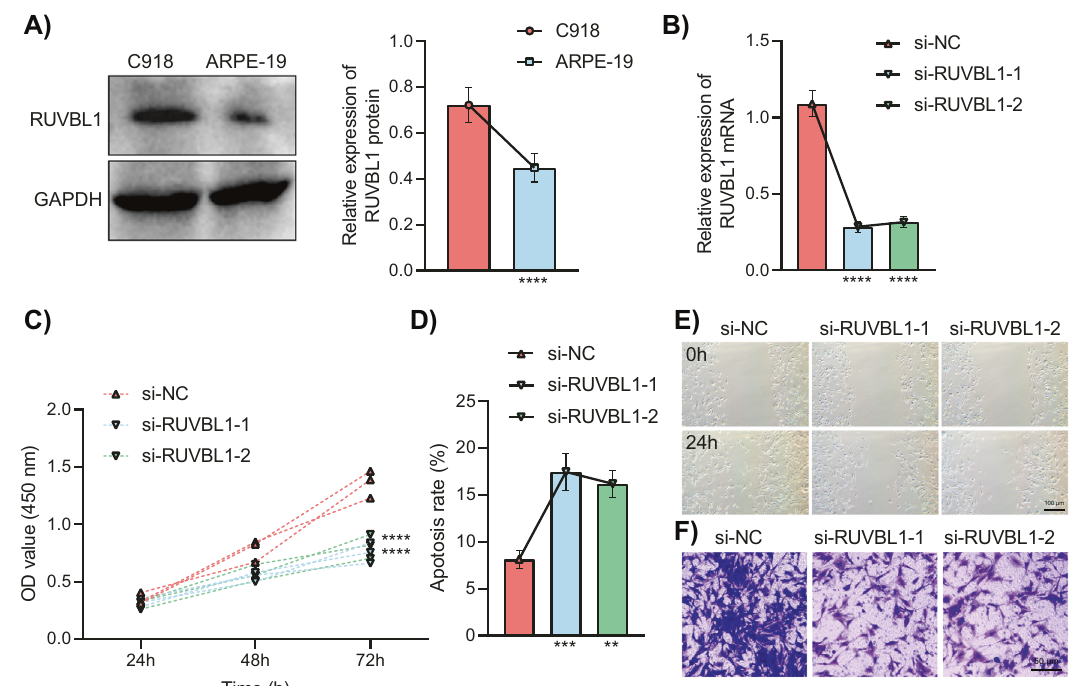
Fig. 5 Effects of RUVBL1 knockdown on the biological properties of UVM cells. A The expression of RUVBL1 in the C918 and ARPE-19 cells determined by Western blot analysis, ****, p < 0.0001. B The relative expression level of RUVBL1 in C918 cells transfected with si-RUVBL1-1 and si-RUVBL1-2 determined by RT-qPCR, **** p < 0.0001. C The proliferative capacity of C918 cells transfected with si-RUVBL1-1 and si-RUVBL1-2 determined by CCK-8 assay; OD values represent the cell viability; higher OD value re fl ects stronger cell proliferation ability, **** p < 0.0001. D The apoptosis rate of C918 cells transfected with si-RUVBL1-1 and si-RUVBL1-2 measured by fl ow cytometry, ** p < 0.01, *** p < 0.001. E The migrative ability of C918 cells transfected with si-RUVBL1-1 and si-RUVBL1-2 detected by scratch assay; the portion of the black shaded area in the middle of the si-RUVBL1-1/2 groups was signi fi cantly larger, highly suggestive of reduced migration ability. F The invasive capacity of C918 cells detected by Transwell assay; the counting suggested that RUVBL1 knockdown signi fi cantly reduced C918 cell invasion